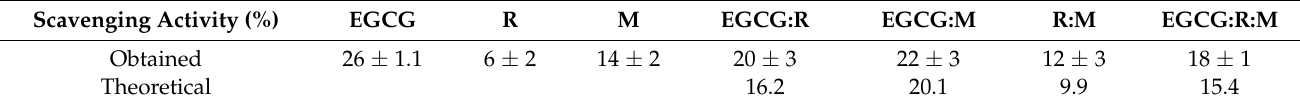
Table 2. Antioxidant activities of EGCG, resveratrol (R), myricetin (M) and mixtures of EGCG:resveratrol, EGCG:myricetin, resveratrol:myricetin and EGCG:resveratrol:myricetin (mean ± SD, n = 3).